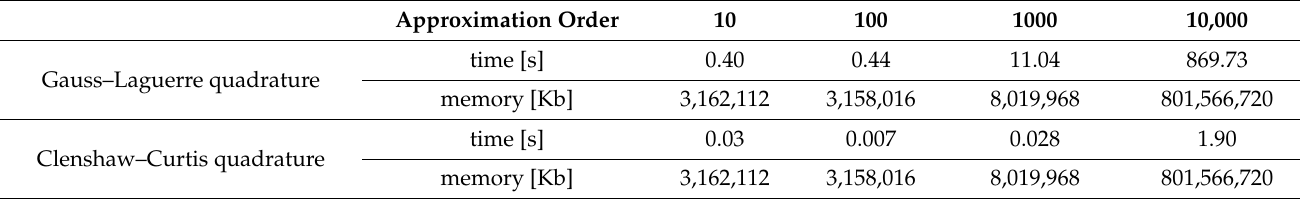
Table 1. Time run and memory performance comparison for proposed